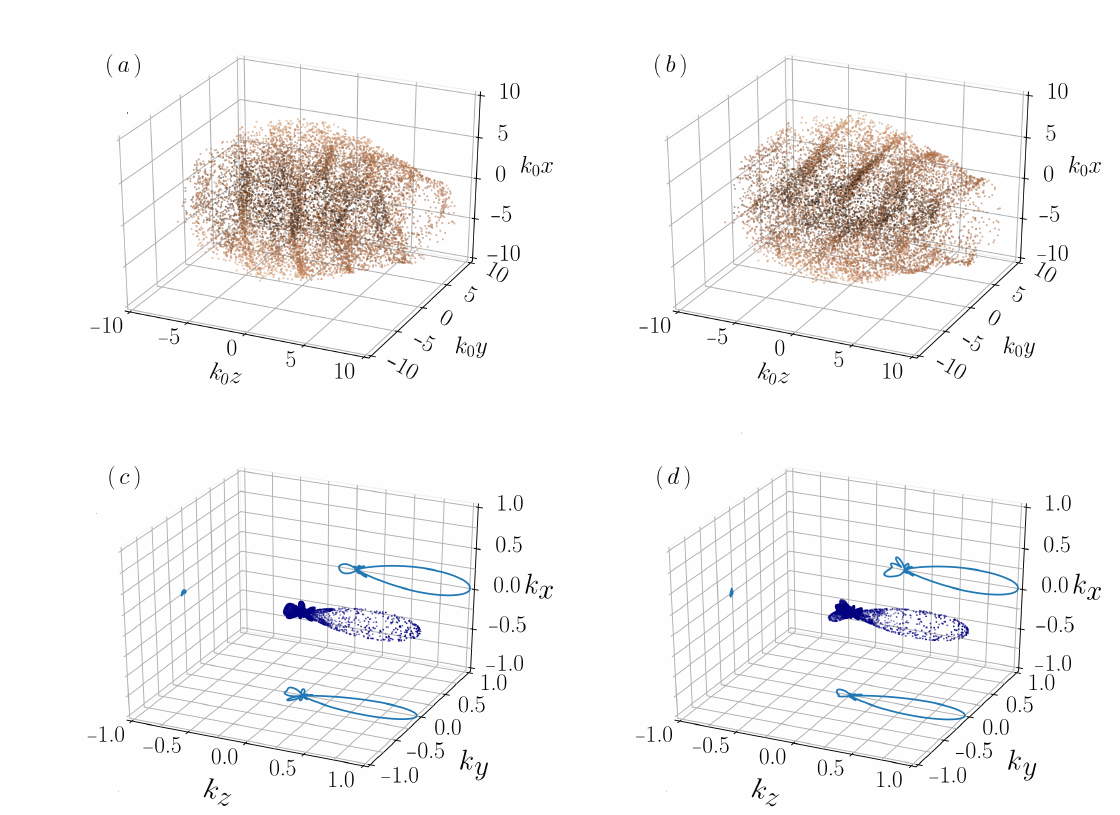
Figure 9. Collective scattering and pattern formation from a 3D spherical atomic cloud with N = 10 4 , with random initial positions, irradiated by a pump field linearly polarized. The outcome for the polarization along the x axis is portrayed in ( a ), whereas the ones for the polarization along the y axis is illustrated in ( b ). In both systems the density grating formation due to collective scattering is pictured at t = 0.180 ω − 1 r . The corresponding bunching factors for both systems, are respectively displayed in ( c , d